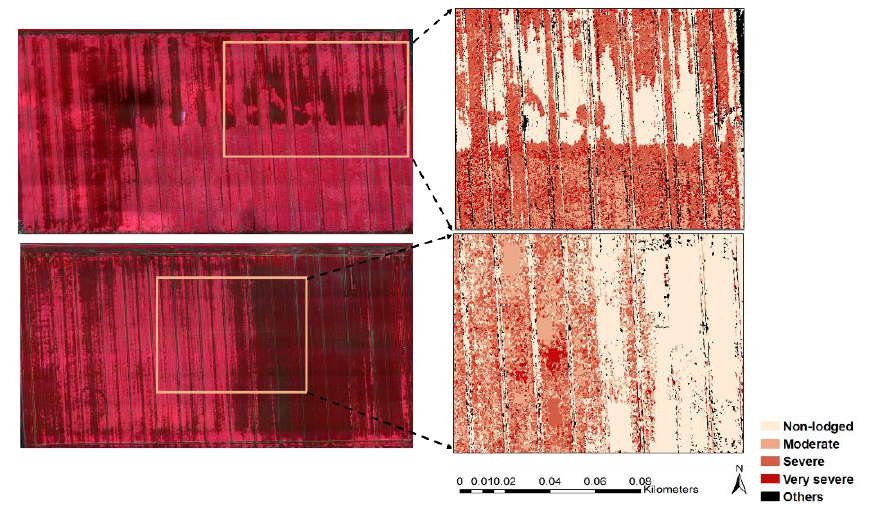
Figure 5. Detection of different grades of lodging severity from the UAV